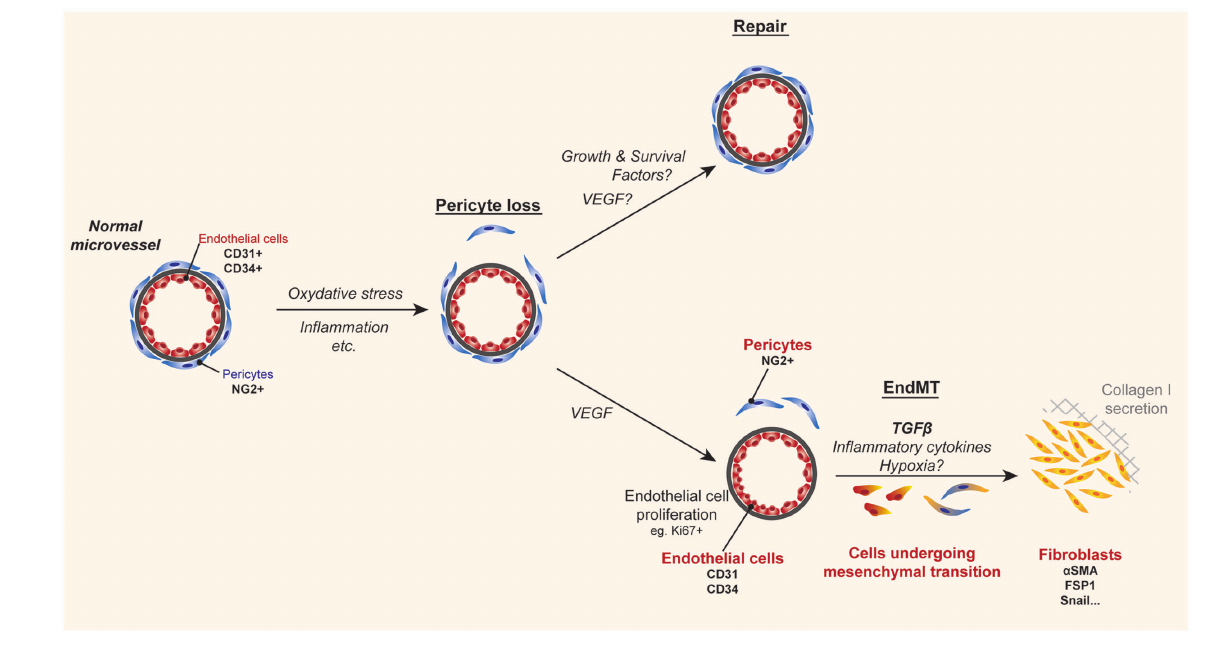
FIGURE 2 | Cartoon illustrating a mechanism of tissue fibrosis associated with allograft rejection. During inflammation, pathological angiogenesis, and/or local hypoxia can lead to pericyte loss. Under normal conditions homeostatic repair occurs under the influence of protective growth and survival factors. In contrast, when the inflammatory microenvironment is sustained, the loss of pericytes serves as a precedent for